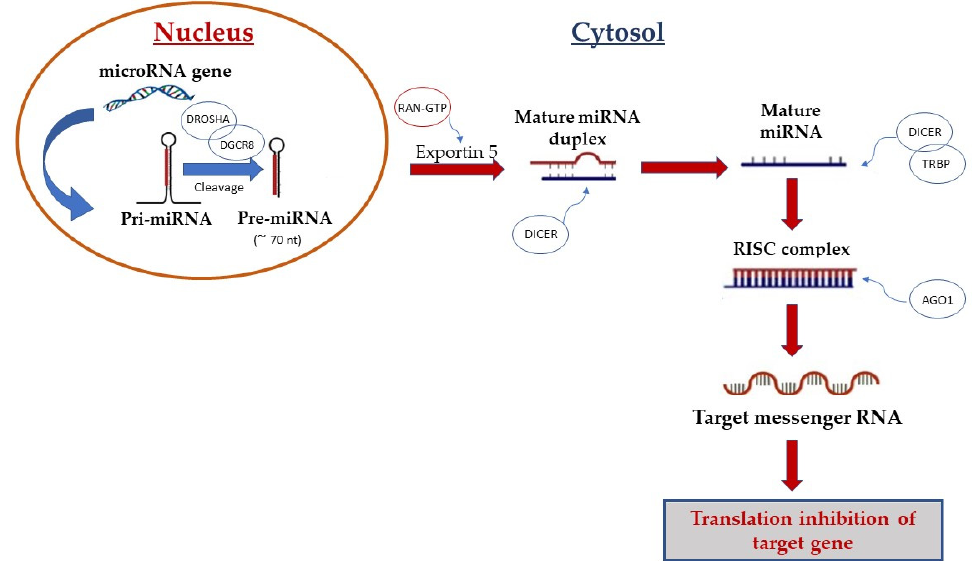
Figure 1. Biogenesis of microRNA. Canonical miRNA biogenesis begins with the generation of the pri-miRNA transcript by RNA polymerase II. The microprocessor complex, comprised of Drosha and DGCR8, cleaves the pri-miRNA to yield the precursor-miRNA (pre-miRNA). The pre-miRNA is transferred from the nucleus into the cytoplasm by Exportin-5 protein. In the cytoplasm, pre-miRNA is processed by Dicer enzymes to produce the mature miRNA duplex. Finally, single-stranded mature miRNA is loaded into the Argonaute (AGO) family of proteins to form the miRNA-induced silencing complex (miRISC).